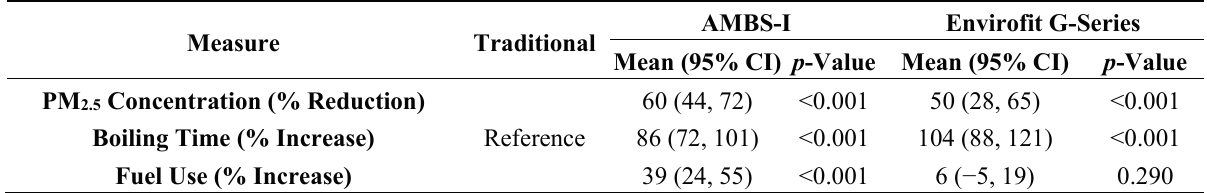
Table 3. Multivariate analysis * of cookstove performance in Study I comparing two alternative cookstoves to a traditional stove in a home setting in rural